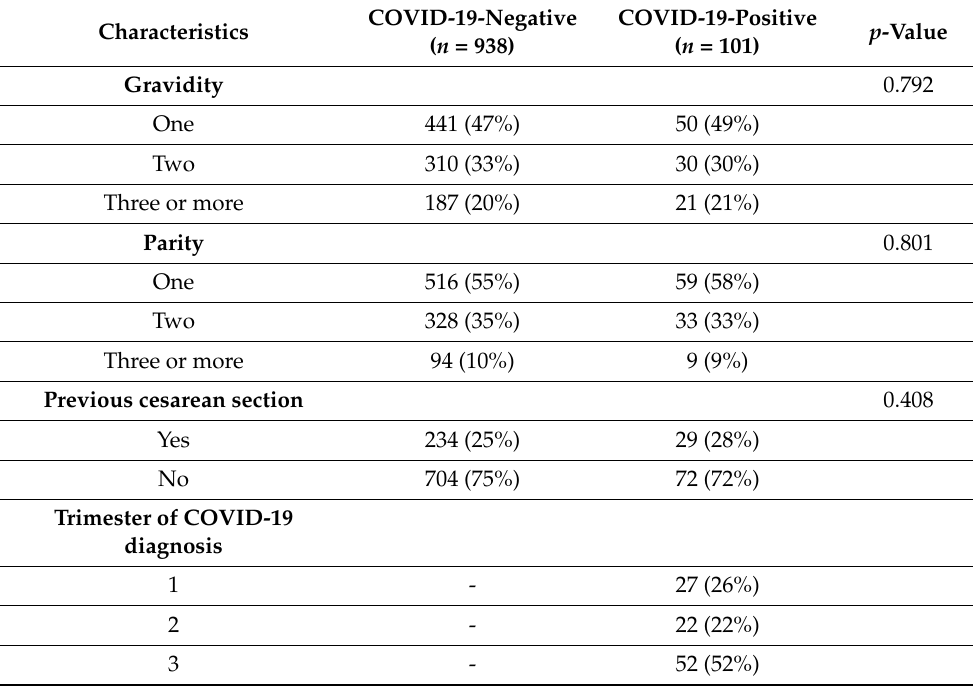
Table 2. Obstetrical characteristics and